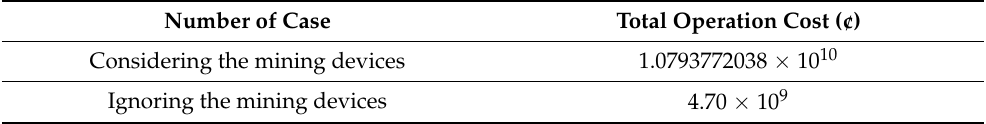
Table 2. Comparative results for the total cost.